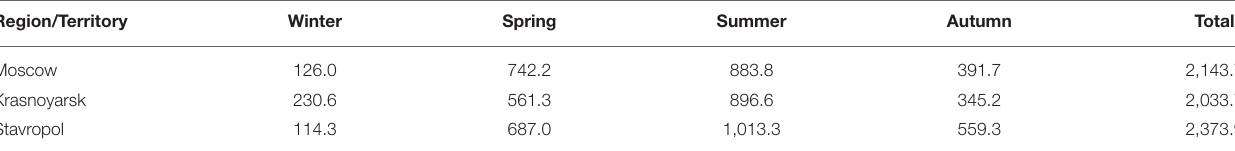
TABLE 3 | Duration of sunshine (hours) for each season for each geographical region included in our study. Region/Territory Winter Spring